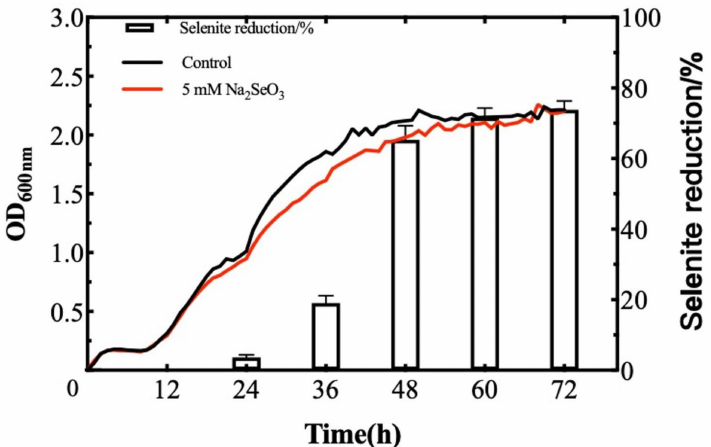
Figure 5. Selenite reduction rate and bacterial growth by strain Y4 at a supplied selenite concentration of 5 mM in LB broth after incubation at 37 ◦ C under the agitation of 180 rpm. Values are mean ± SD of three